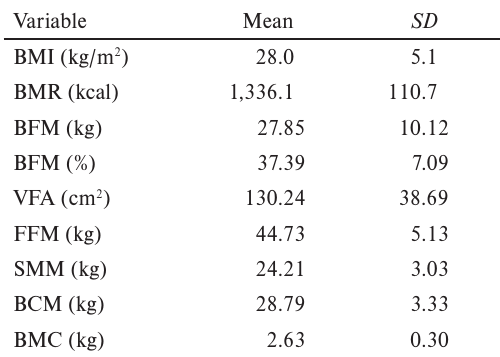
The selected parameters of body composition Classification of BMI, FMI and FFMI in women – modi-